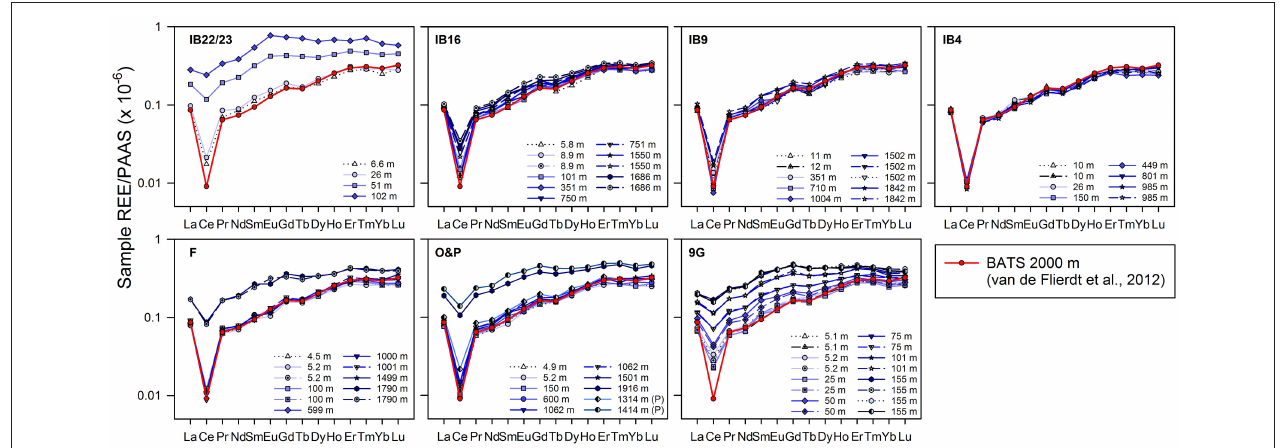
FIGURE 5 | REE concentrations normalised to the Post-Archaean Australian Shale (PAAS) values of Taylor and McLennan (1985) as presented in Freslon et al. (2014). The BATS 2000m pattern (van de Flierdt et al., 2012) is shown for comparison in each panel (bold red line). To note, surface waters from O and all 9G samples were not